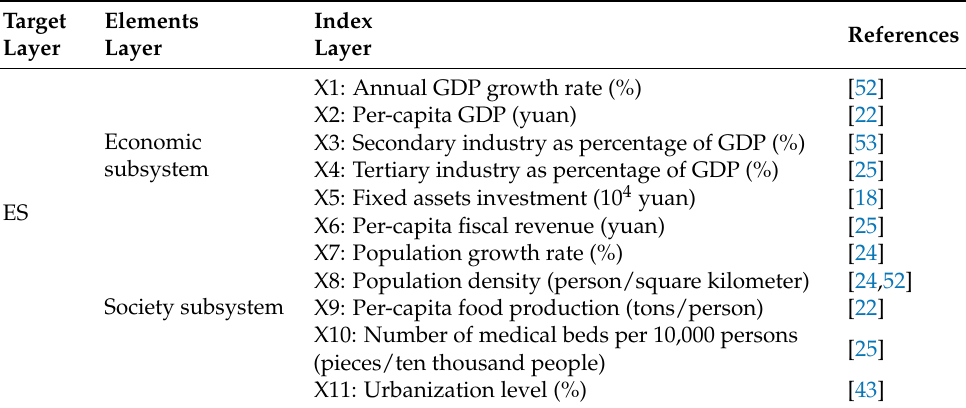
Table 2. The index system of ecological security evaluation in border